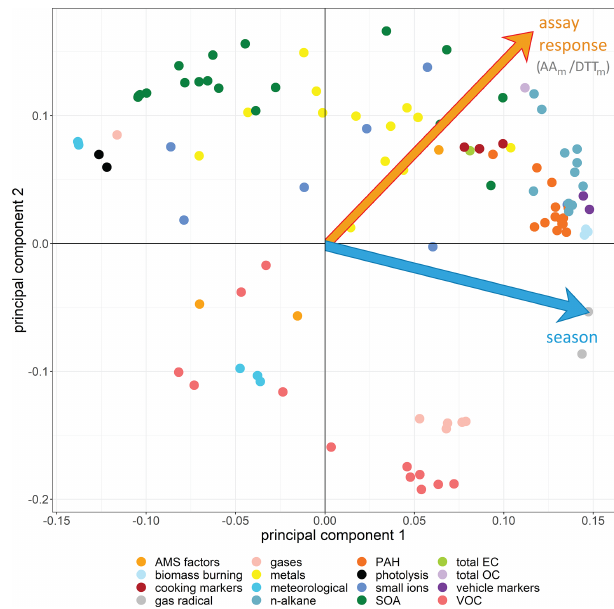
Figure 7. Principal component analysis loadings plot for all data points. Points are coloured by measurement category; fully labelled loadings are provided in Fig. S14. The plot is annotated with the same orientation as the score plot to indicate the direction of visu- alised trends for selected assays and for season from the latent vari- able origin as shown in Fig. 6. In PC 1, the winter classification is driven by increased gas radicals, n -alkanes, PAH, vehicle markers, biomass burning markers, total OC and selected metals and SOA markers; the summer classification is driven by increased tempera- ture and photolysis, ozone (the single gas species in this section of the plot), selected SOA markers and metals, and selected VOCs. In PC 2, high AA m and DTT m response is associated with increased SOA, transition metals, cooking markers, n -alkanes and PAH con- centrations in samples; low AA m and DTT m response associated with low VOCs, gases and selected meteorological parameters (rel- ative